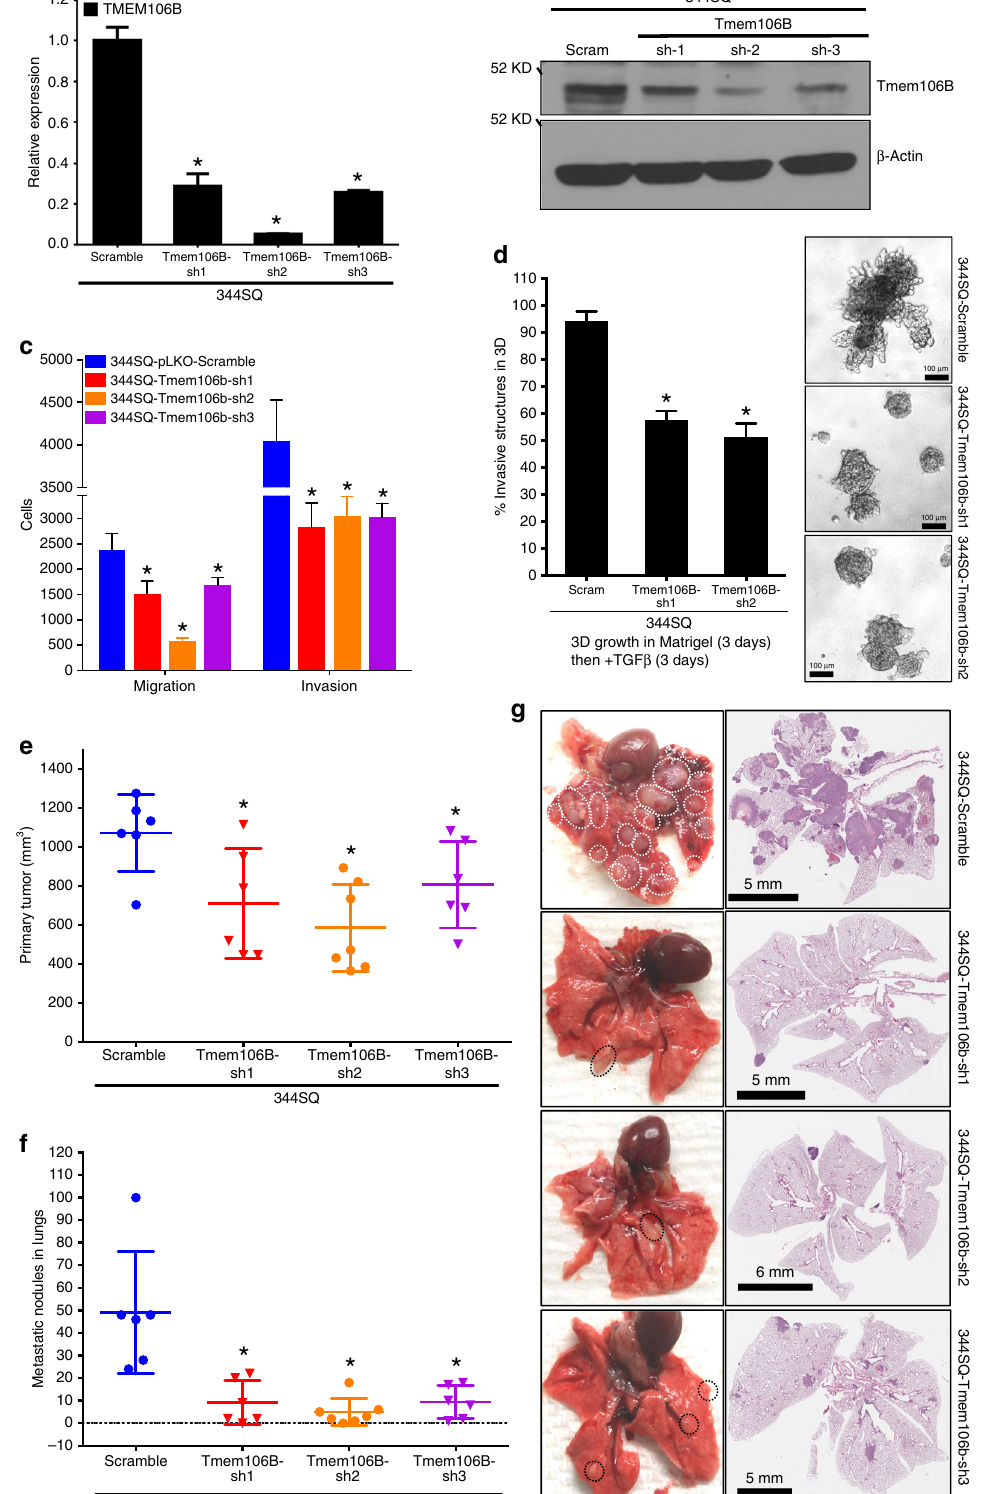
TMEM106B , its expression was stably inhibited by shRNAs tar- geting different segments of the TMEM106B mRNA in the highly cells, 344SQ and 344LN ( TMEM106B -sh1 – sh3; Fig. 2a, b and